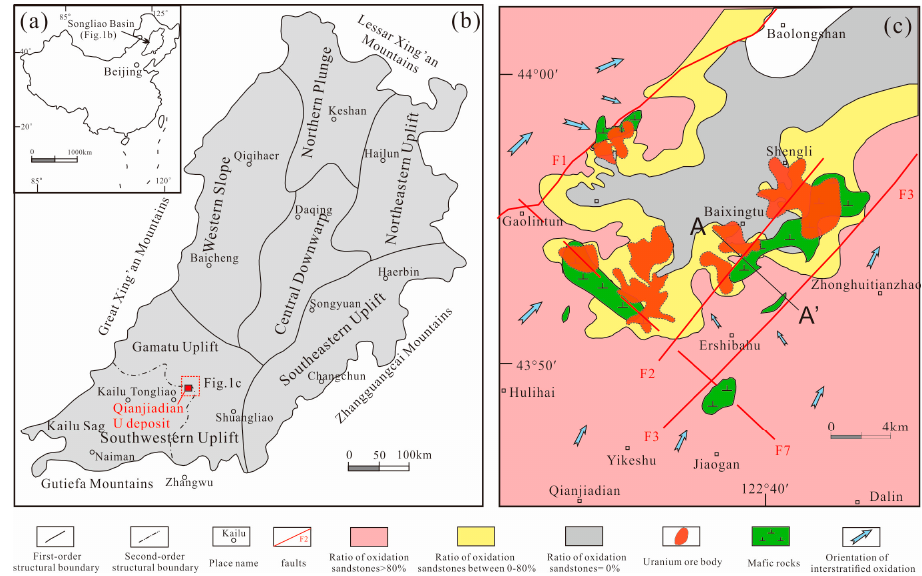
Figure 1. ( a ) A sketch map showing the location of the Songliao Basin. ( b ) Tectonic units of the Songliao Basin (modified from [35]). ( c ) Spatial distribution of the interstratified oxidation and mafic rocks in the Qianjiadian uranium deposit, modified after [34] and [19].